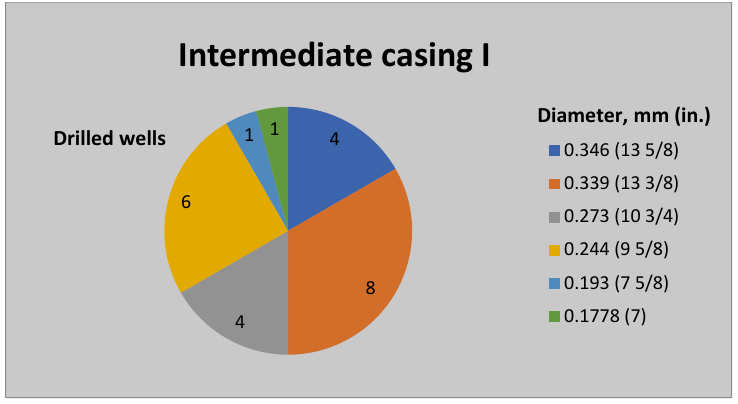
Figure 10. Diameter of intermediate casing I in the 24 analyzed wells.